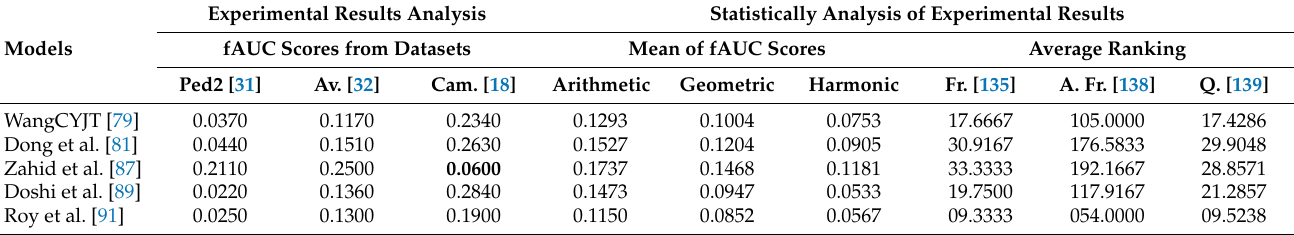
Table 7. Multiple comparison test for G 2 using fAUC. Column-wise the best numerical result is shown in bold